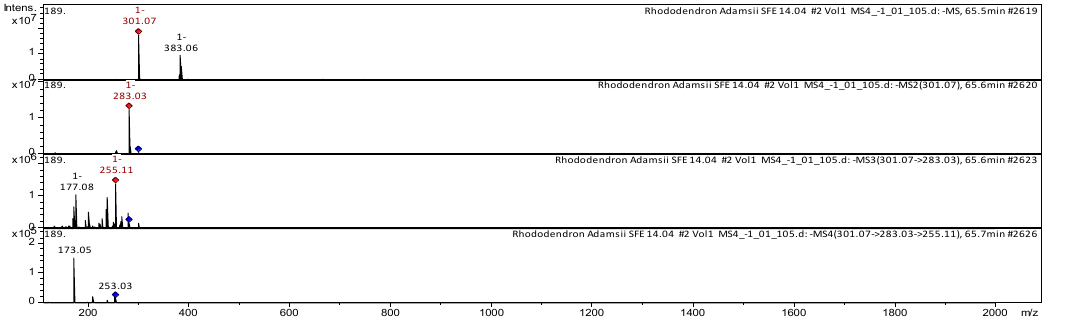
Figure 6. CID spectrum of quercetin from Rh. adamsii , m/z 301.07.